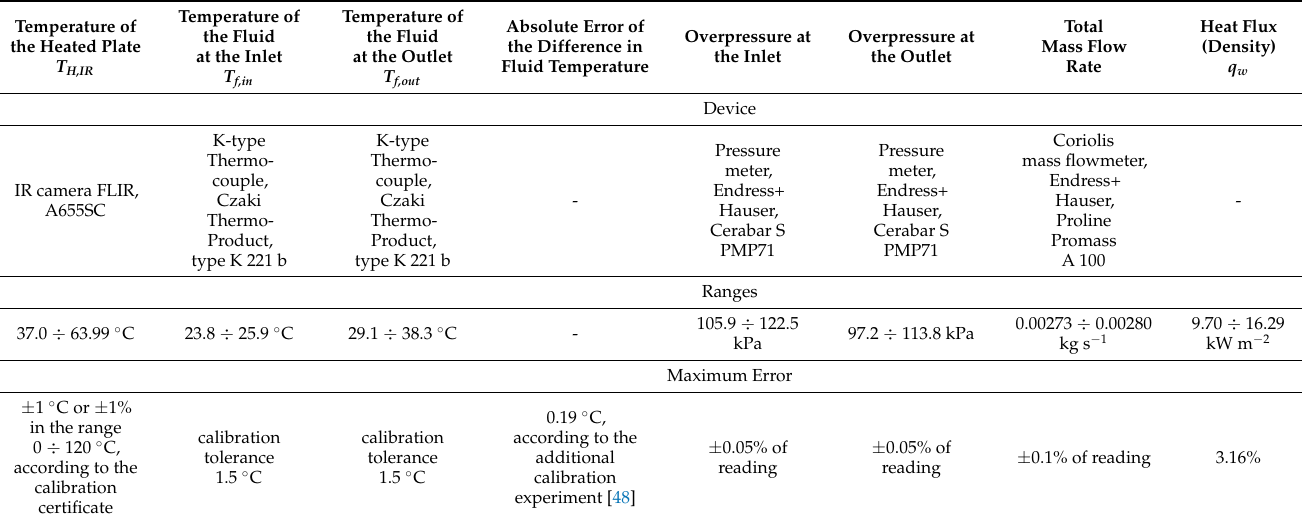
Table 1. Basic experimental thermal-flow parameters and accuracies.